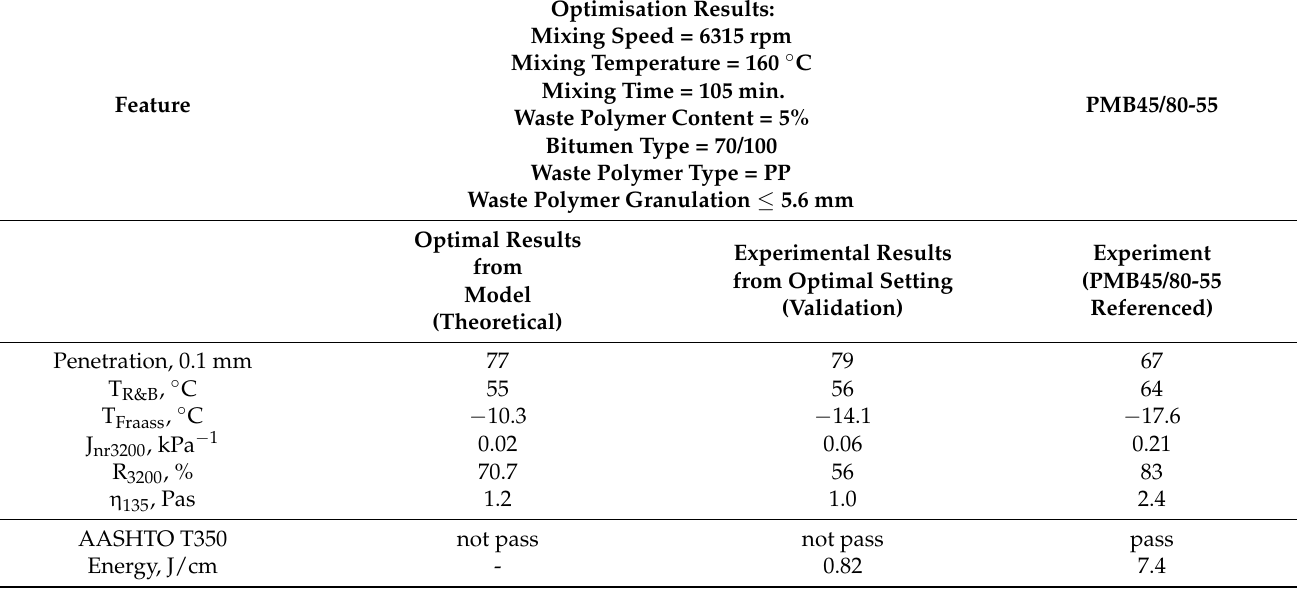
Table 8. Results of the optimal solution